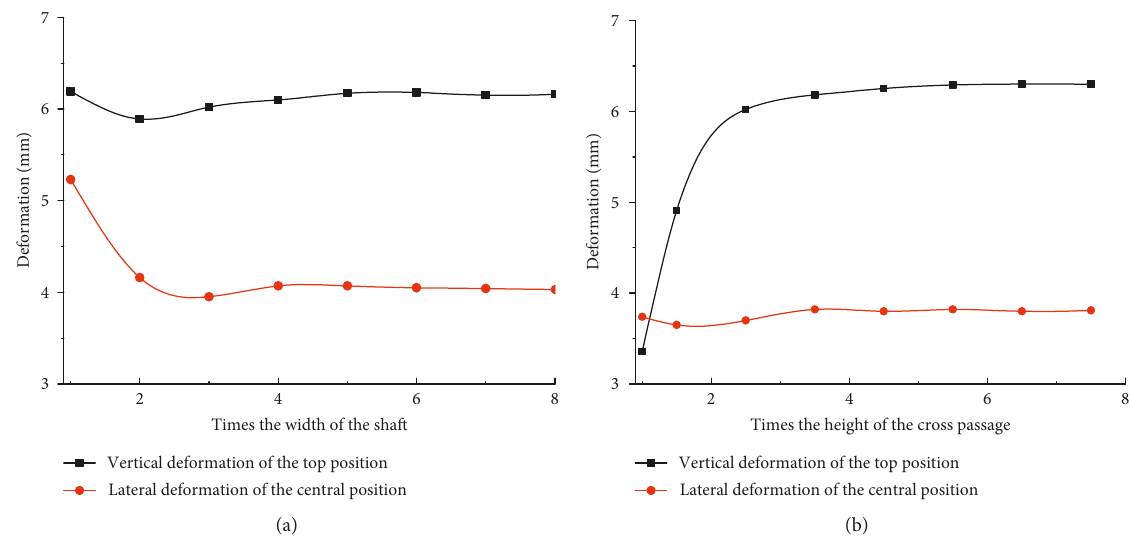
Figure 12: Deformations of the selected points in the horsehead section with different boundaries. (a) Deformations with different side boundaries. (b) Deformations with different bottom boundaries.